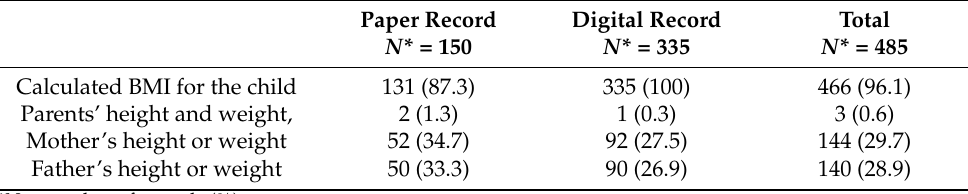
Table 1. Frequencies of documented variables regarding the child and their parents. Paper Record